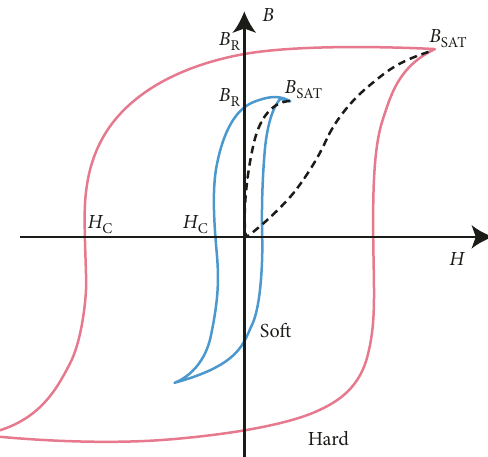
Figure 1: Diagram of B – H hysteresis curve for a hard and a soft ferromagnetic Table 1: Magnetic properties of different engineering materials.